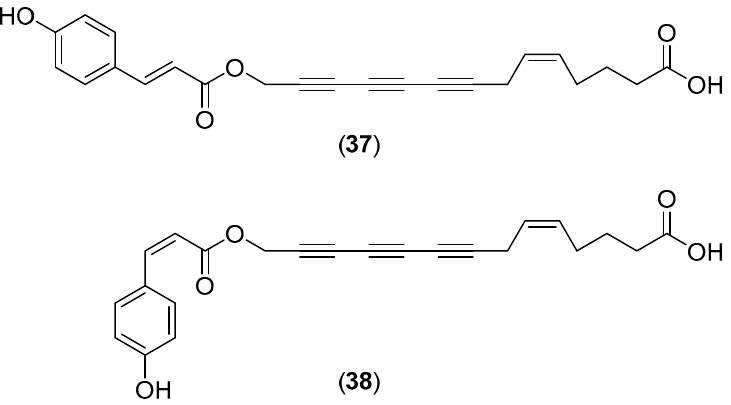
Figure 7. Chemical structures of selected compounds isolated from Fistulina hepatica.